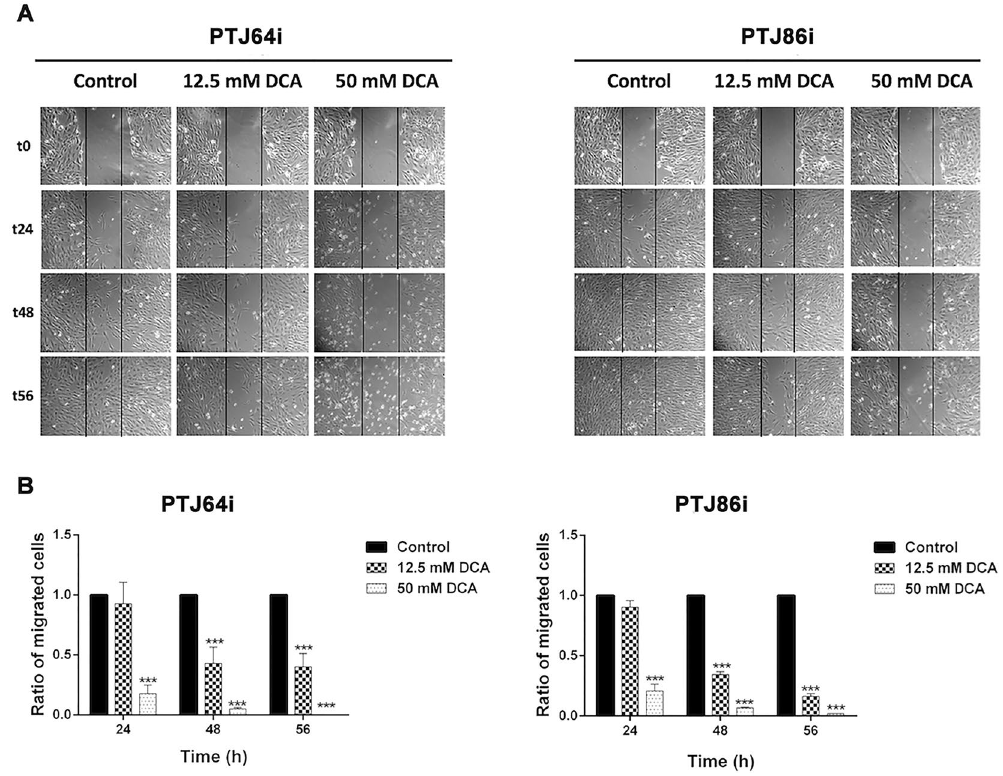
Figure 6. Effect of DCA on wound healing. (A) Representative wound-healing assay pictures for PTJ64i and PTJ86i cells treated with vehicle or with DCA (12.5 and 50 mM) are shown. Pictures of PGL cells were taken at 0, 24, 48 and 56 hours to analyze the dynamics of wound closure (vertical lines indicate wound edges); (B) Histograms represent quantitative analyses of cell migration and are expressed as the ratio of the number of migrated cells in three fields after treatment as compared with vehicle ( *** p < 0.001).